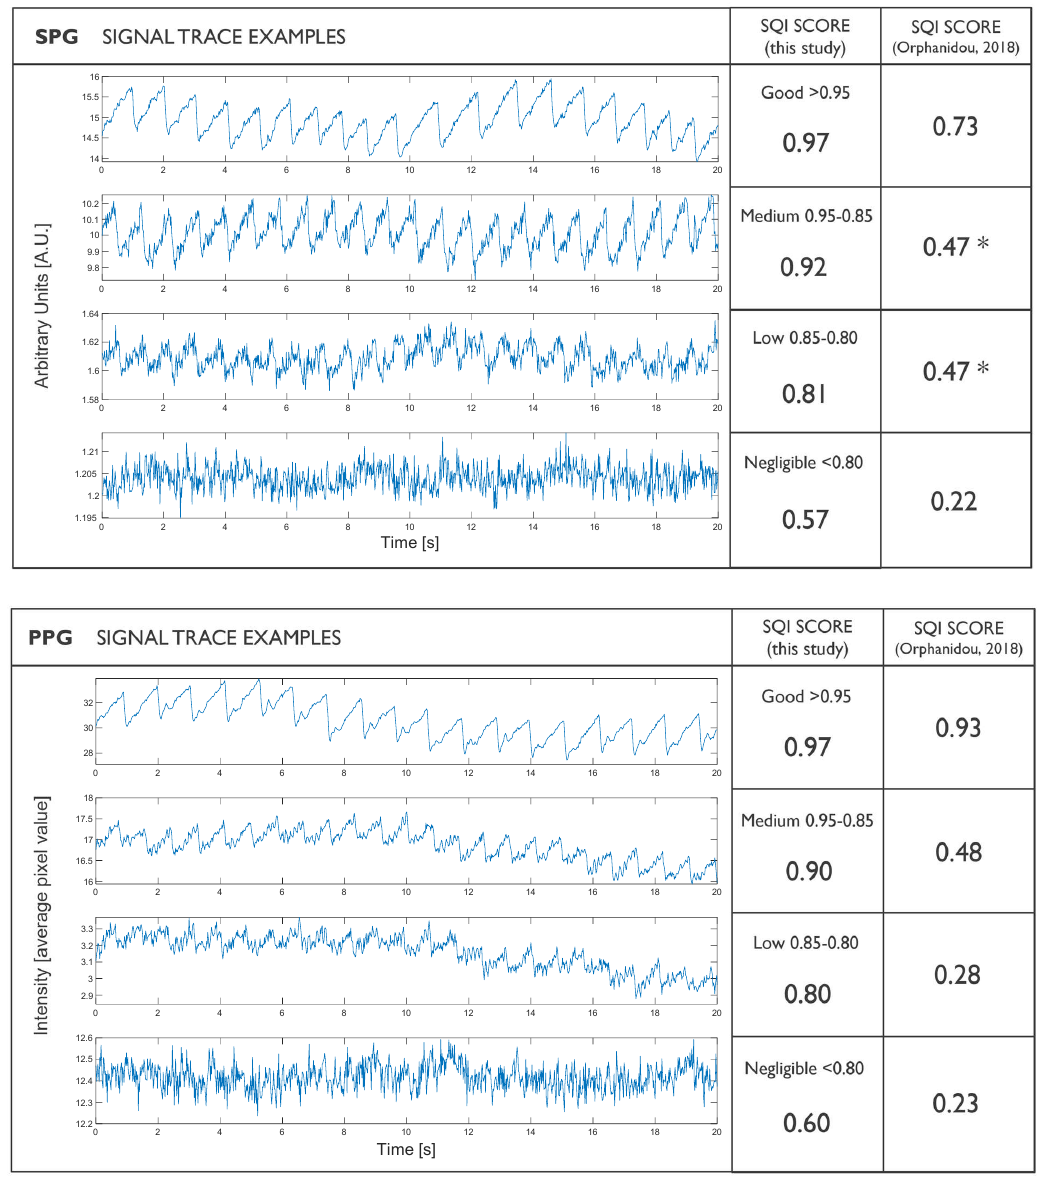
Figure 19. Comparison between SQI scales used in this study and a sophisticated widely used SQI template specifically developed for PPG. The template PPG SQI works better for PPG, although it does not work well for SPG. * Note the SPG values marked with an asterisk, which score as medium and low with our SQI scale, whereas both scored the same 0.47 value with the template SQI method.